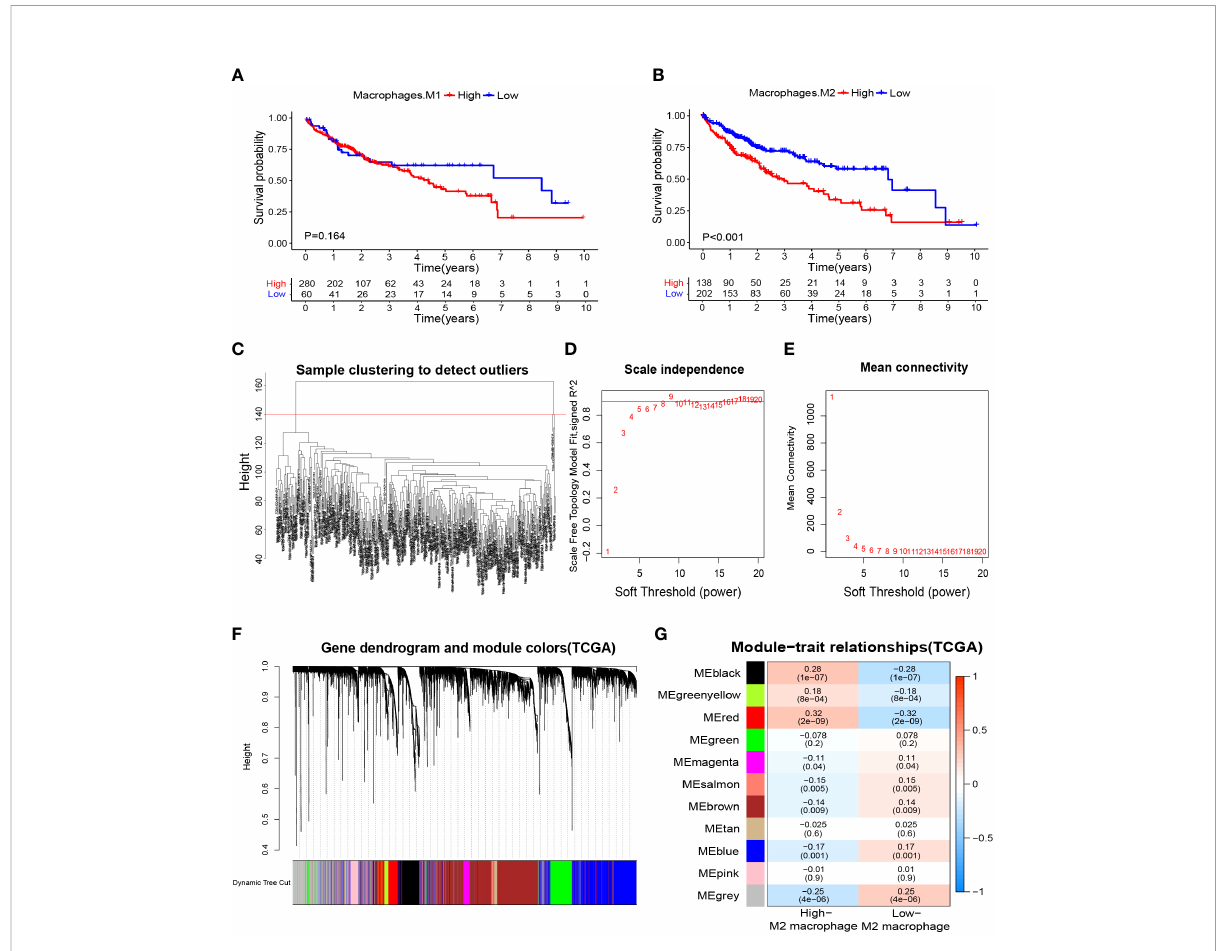
FIGURE 2 Macrophage-related survival analysis and screening of M2 macrophage related genes. (A) Kaplan – Meier survival curves showed no difference in the prognosis between groups with high and low content of M1 macrophages. (B) The prognosis was signi fi cantly worse in the group with high content of M2 macrophages. (C) Samples were clustered and outlier samples were not found. (D, E) According to the instructions of the WGCNA package, 7 was selected as the soft threshold power. (F, G) Correlation analysis of modules with traits yielded 10 non-gray modules, with the red module considered to be the most relevant module for M2 macrophages. WGCNA, weighted gene co-expression network